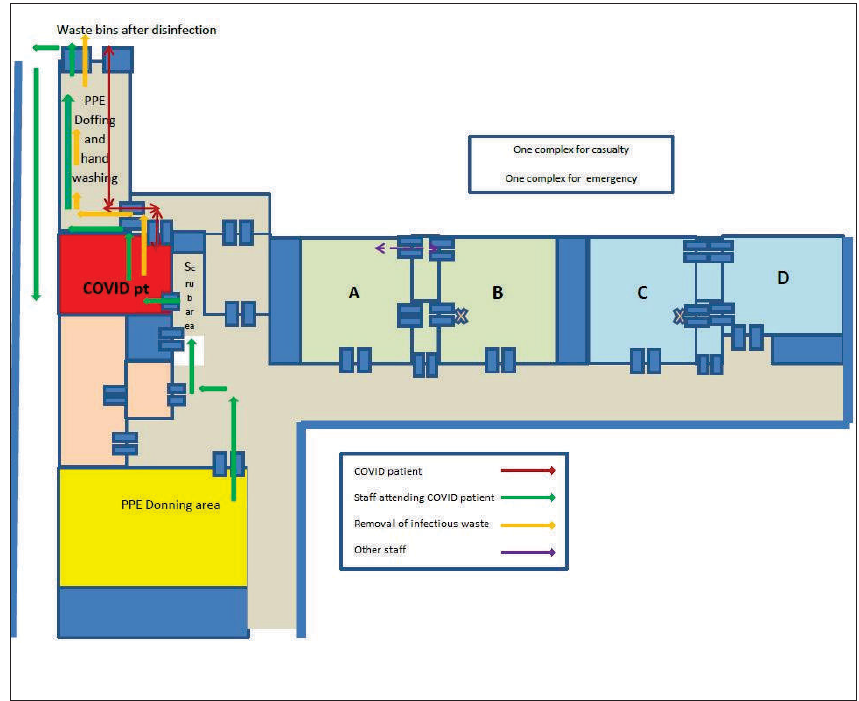
Figure 2: Theatre plan for surgicalprocedures of COVID-19